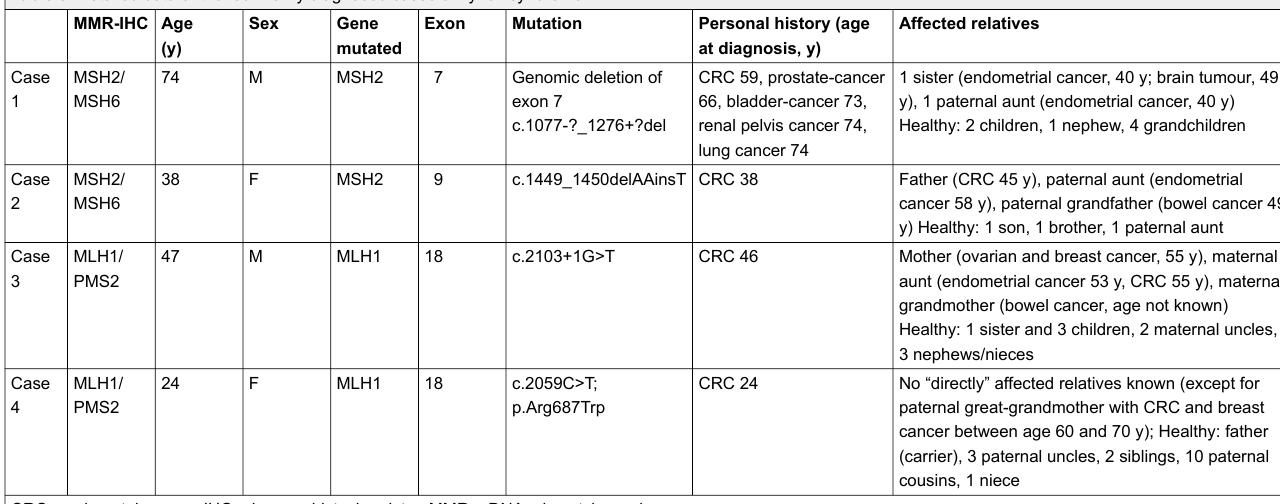
Table 3 : Detailed data of the four newly diagnosed cases of Lynch